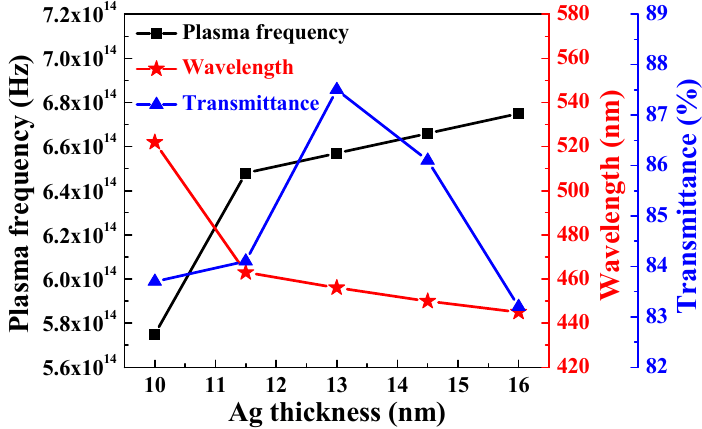
Figure 5. Plasma frequency of the α -IGZO/Ag/ α -IGZO triple-layer structure as a function of thickness of Ag film.